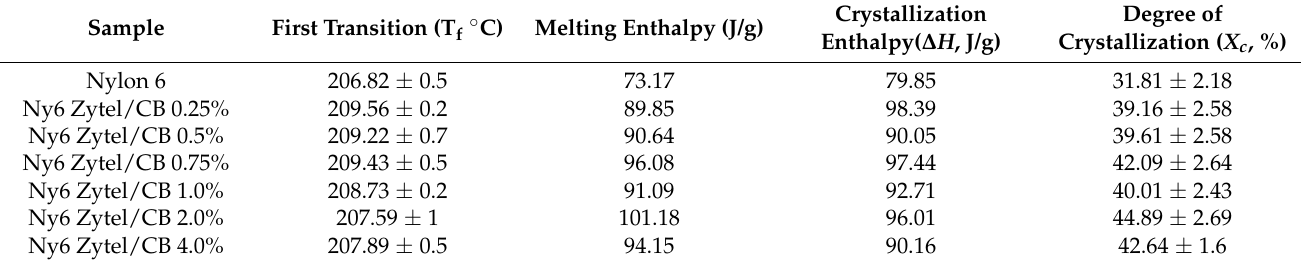
Table 3. Melting enthalpy (J/g), crystallization enthalpy ( ∆ H , J/g), crystalline ( X c ) Nylon 6 nonwoven fabrics, and Ny6 Zytel/CB nonwoven fabrics to different concentrations of 0.25, 0.5, 0.75, 1.0, 2.0, and 4.0